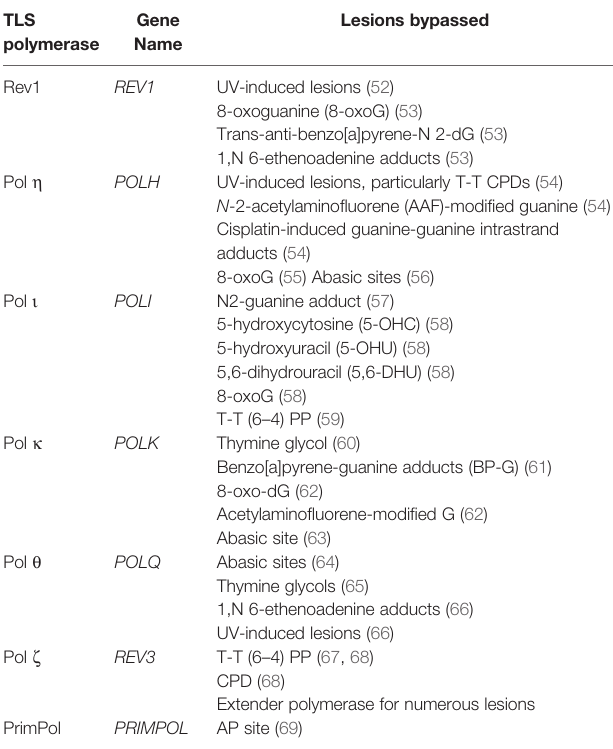
TABLE 1 | Examples of lesion bypass by human TLS polymerases. TLS